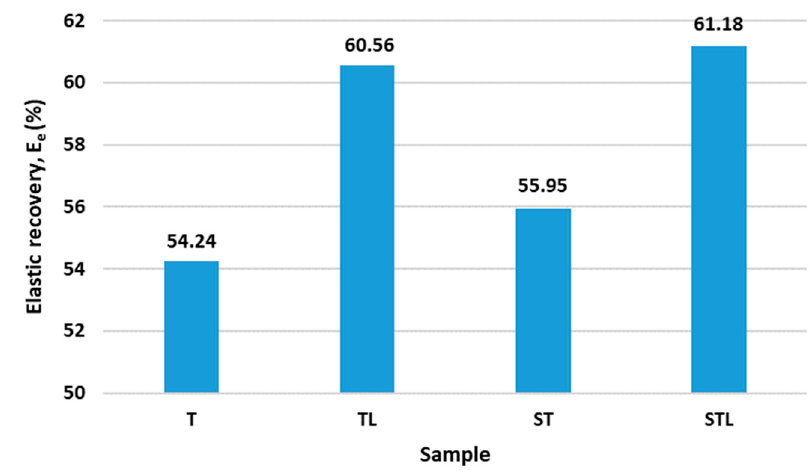
Figure 3. The results of elastic recovery after compression loading.